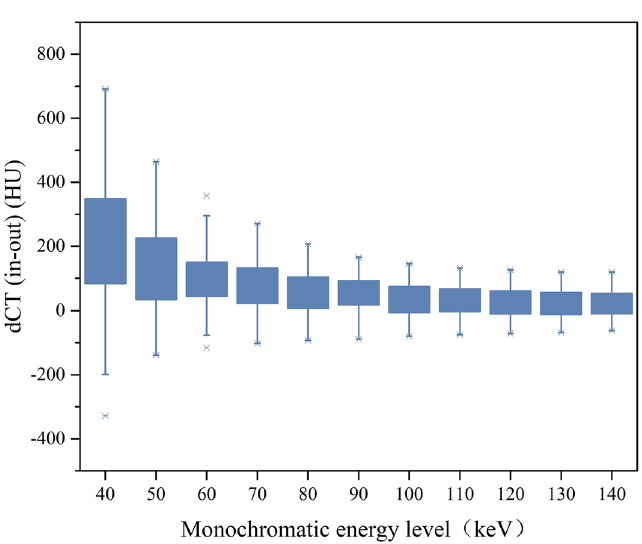
Figure 3. Comparison of dCT (in–out) at monochromatic energy levels between 40 and 140 keV in 10-keV